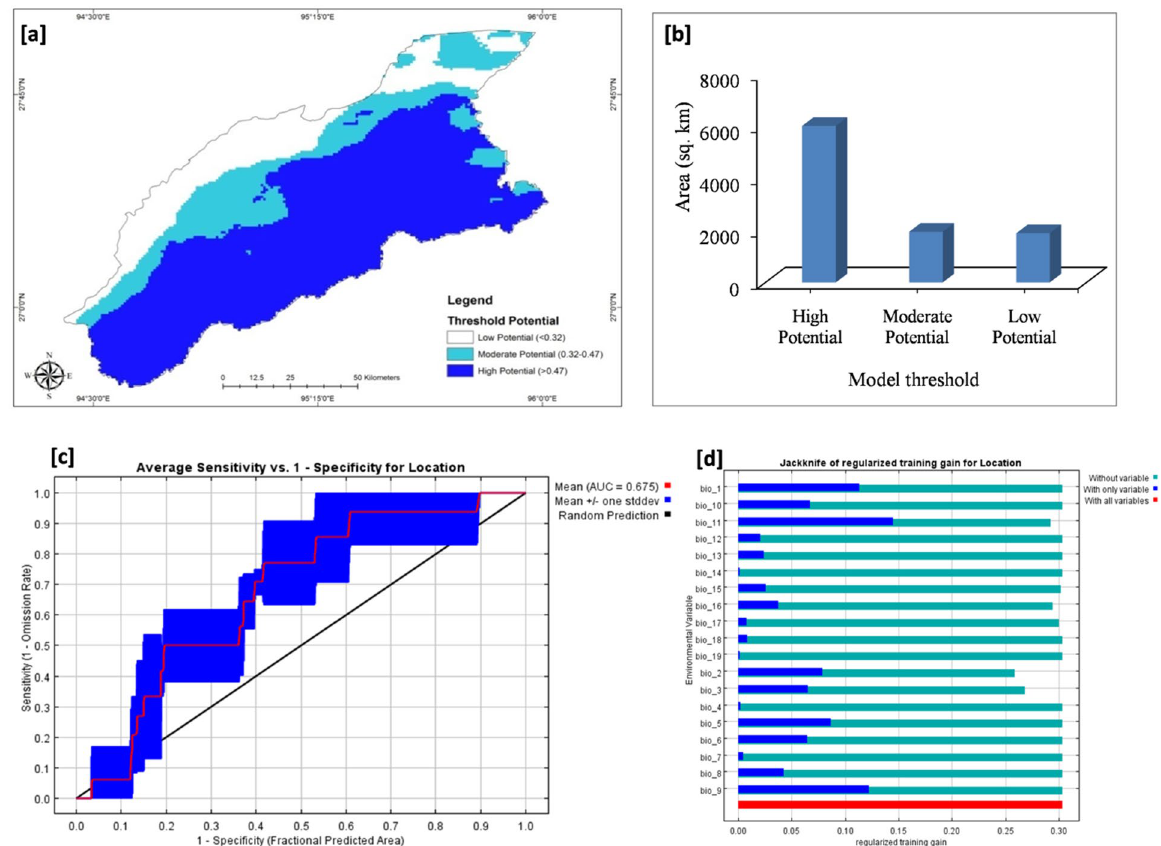
Figure 2. Maxent results ( a ) predictive distribution map prepared using Maxent 3.1 and ArcGIS 10.3 ( b ) area statistics in different model thresholds ( c ) ROC curve and ( d ) Jackknife validation output.